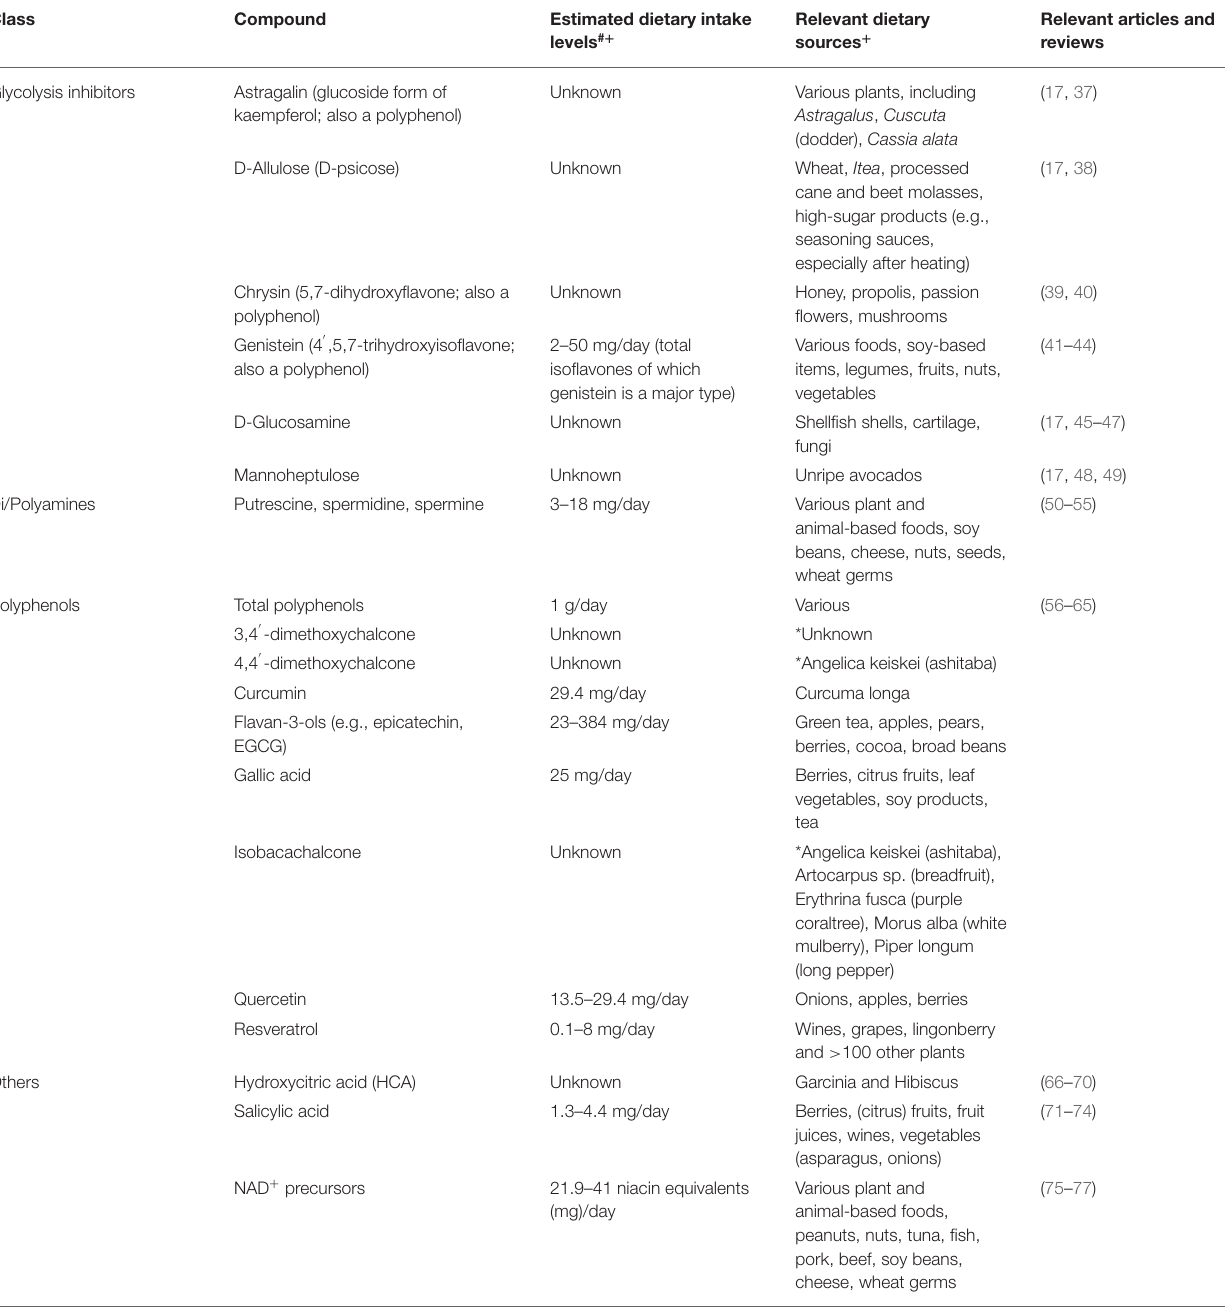
TABLE 1 | Summary of selected dietarily available compounds with Caloric Restriction Mimetic properties, their estimated intake levels, food sources, and comprehensive literature